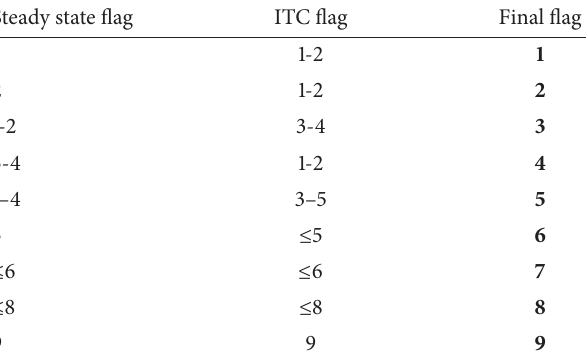
Table 1: Overall flag system after Foken